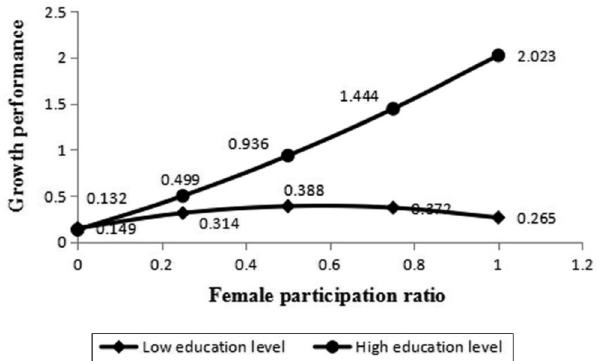
Figure 1. Moderating effect to inverted U-shape relationship